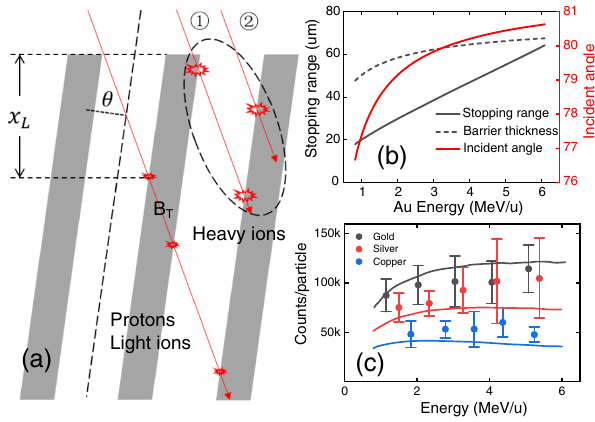
FIG. 6. (a) Schematic of ions interacting with the MCP. The bomb symbols show the generation of secondary electrons on the surface of MCP channels. (b) Stopping range (black solid line) of Au ions in MCP materials and the barrier thickness (black dashed line) needed to pass through and enter into another channel, depicted as B . The incident angle θ is shown by the red solid T line. (c) Responses of heavy ions obtained from experiments (solid dots) and from calculations (solid